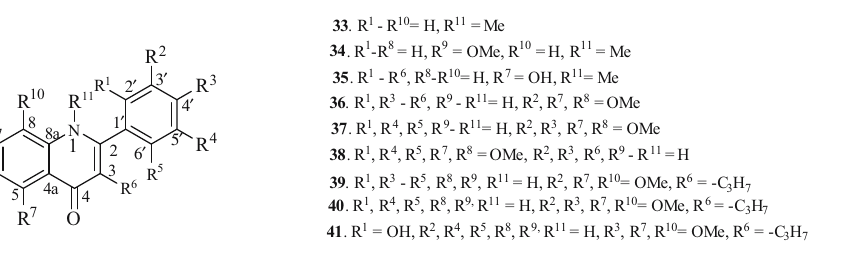
Figure 5: Structures of quinolinone and quinolone alkaloids from Casimiroa